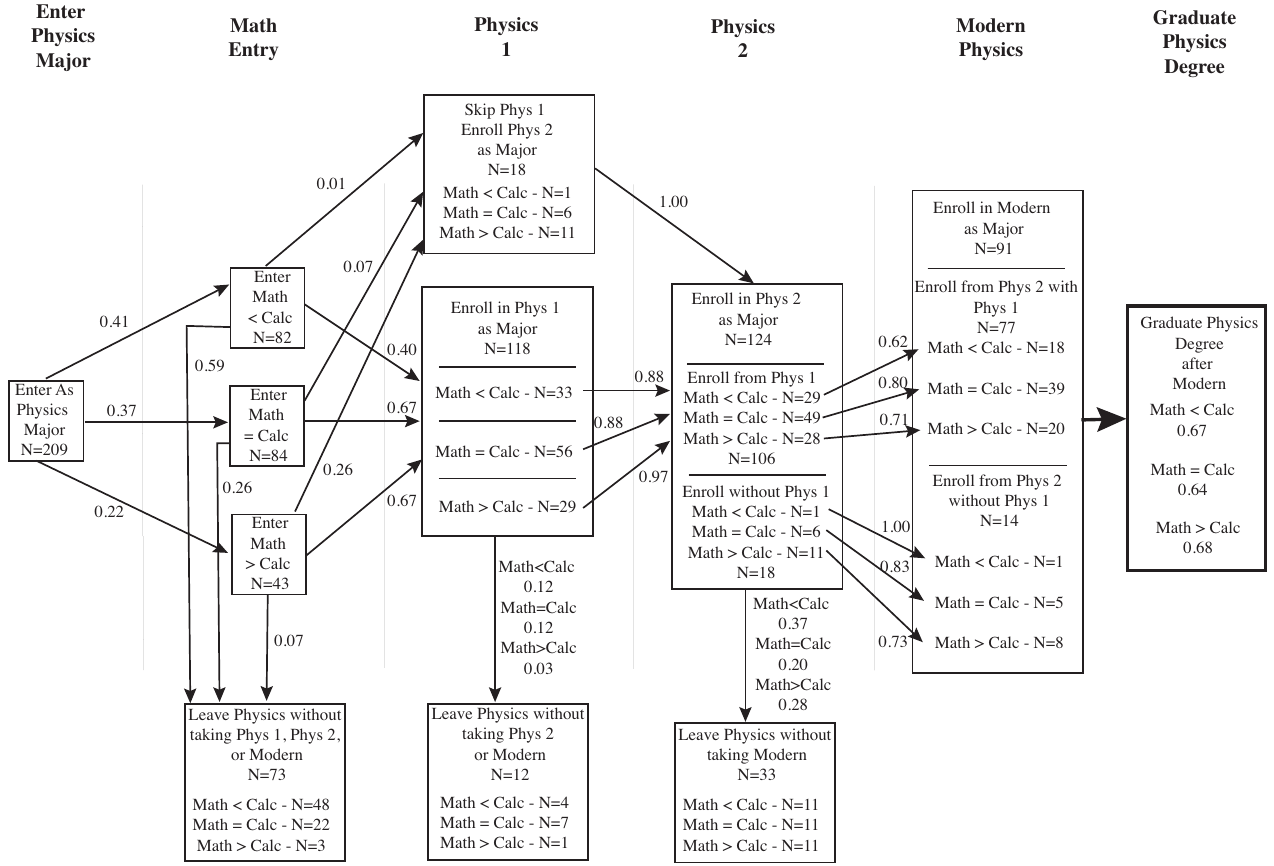
FIG. 4. Traversing the major from entry to Modern Physics for students at Institution 1 who elect a physics major in their first semester. The figure uses the abbreviations < Calc for students whose first mathematics class is less advanced than Calculus 1, Calc for students whose first mathematics class is is Calculus 1, and > Calc for students whose first mathematics class is more advanced than Calculus